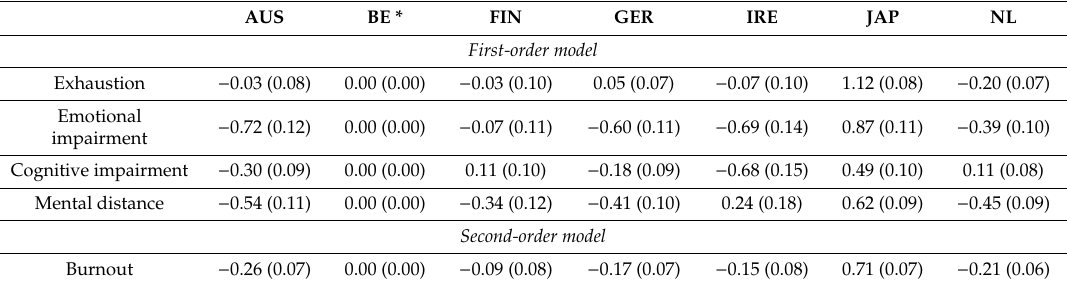
Table 4. Means (standard errors) of the latent variables as estimated in the